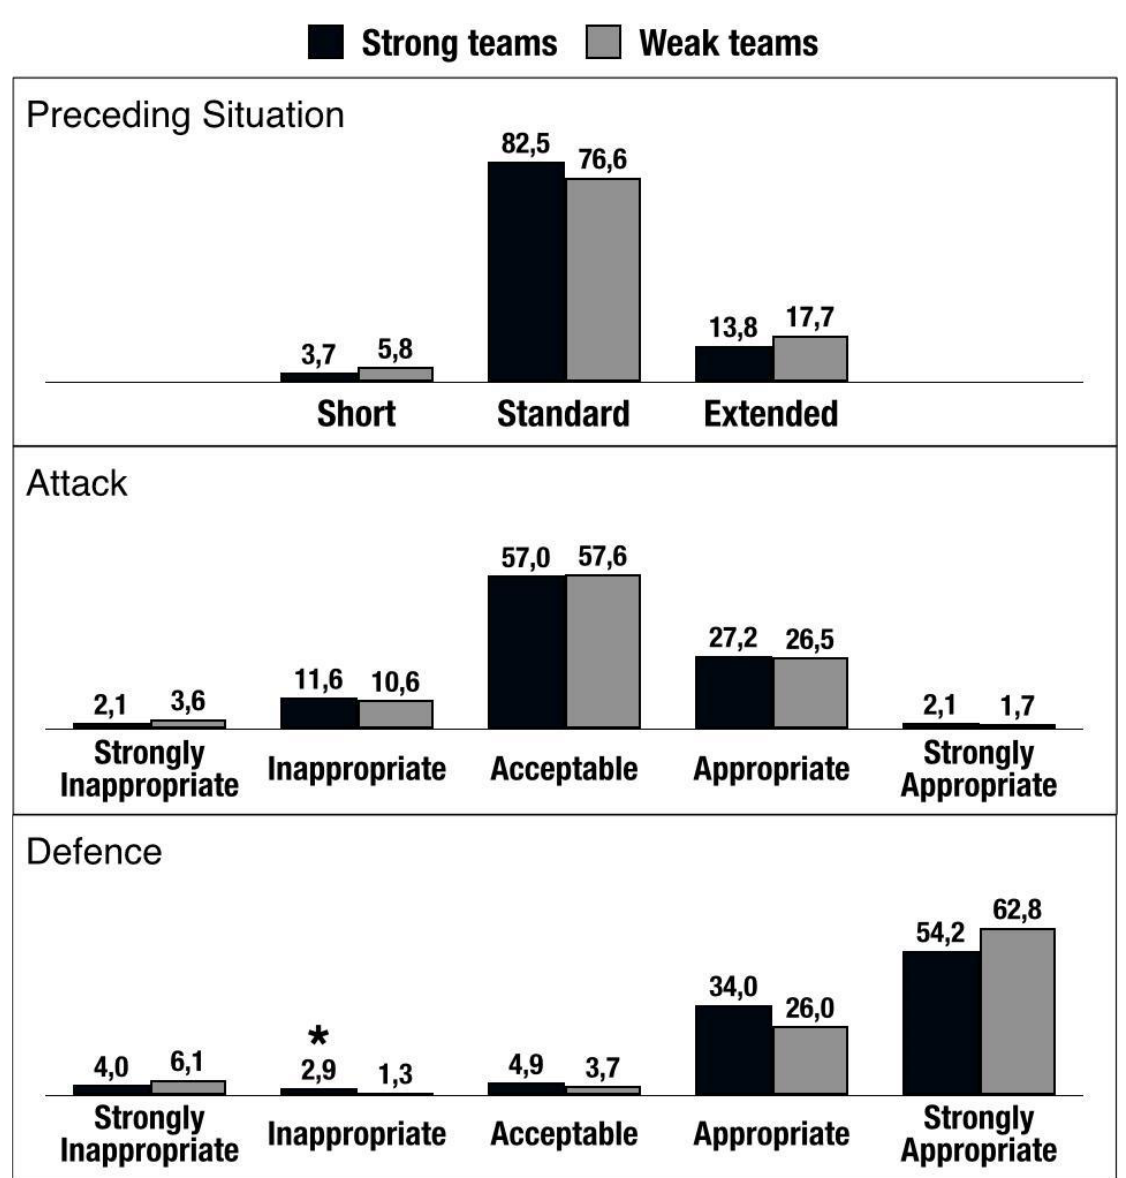
Figure 2 . Mean percentage of relative quality in team level comparison between strong vs. weak teams. Note: * p <